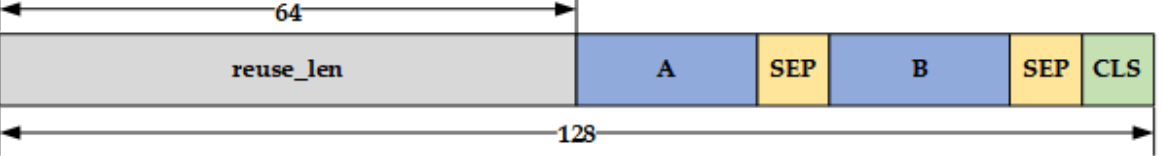
Figure 2. Structure of “input”.